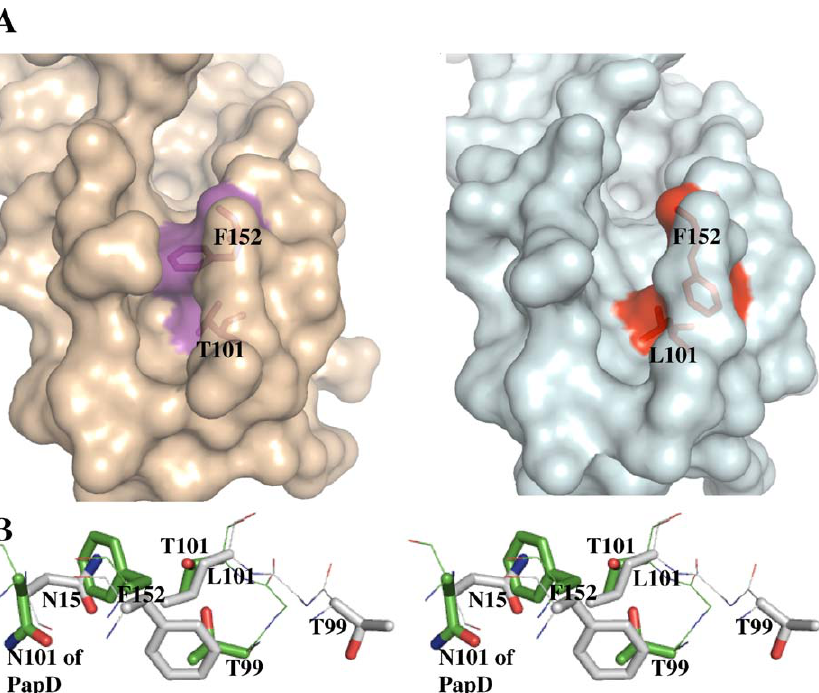
Figure 4. Comparison of PapD/PapA Ntd1_G15N and PapD/PapA Ntd1_G15N_T101L (A) Surface representation of dscPapA in PapD/PapA Ntd1_G15N (left) and dsePapA in PapD/(PapA Ntd1_G15N_T101L ) 2 (right). The residues in the groove at the P4 position (F152 [purple and red in left and right panels, respectively]) and the one at the P5 position (T101 [purple] or L101 [red]) are indicated. (B) Stereo view of a superimposition of the residues involved in DSE at the P4 and P5 positions. The green residues are N101 (PapD), F152, T101, and T99 (dscPapA in PapD/PapA Ntd1_G15N ), whereas the gray residues are N15 (PapA Nte), F152, L101, and T99 (dsePapA in PapD/(PapA Ntd1_G15N_T101L ) 2